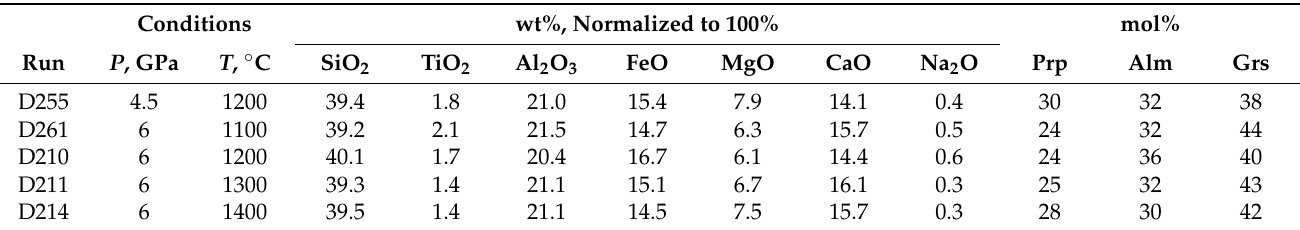
Table 5. Composition of garnet in the system L(S)+L(C).